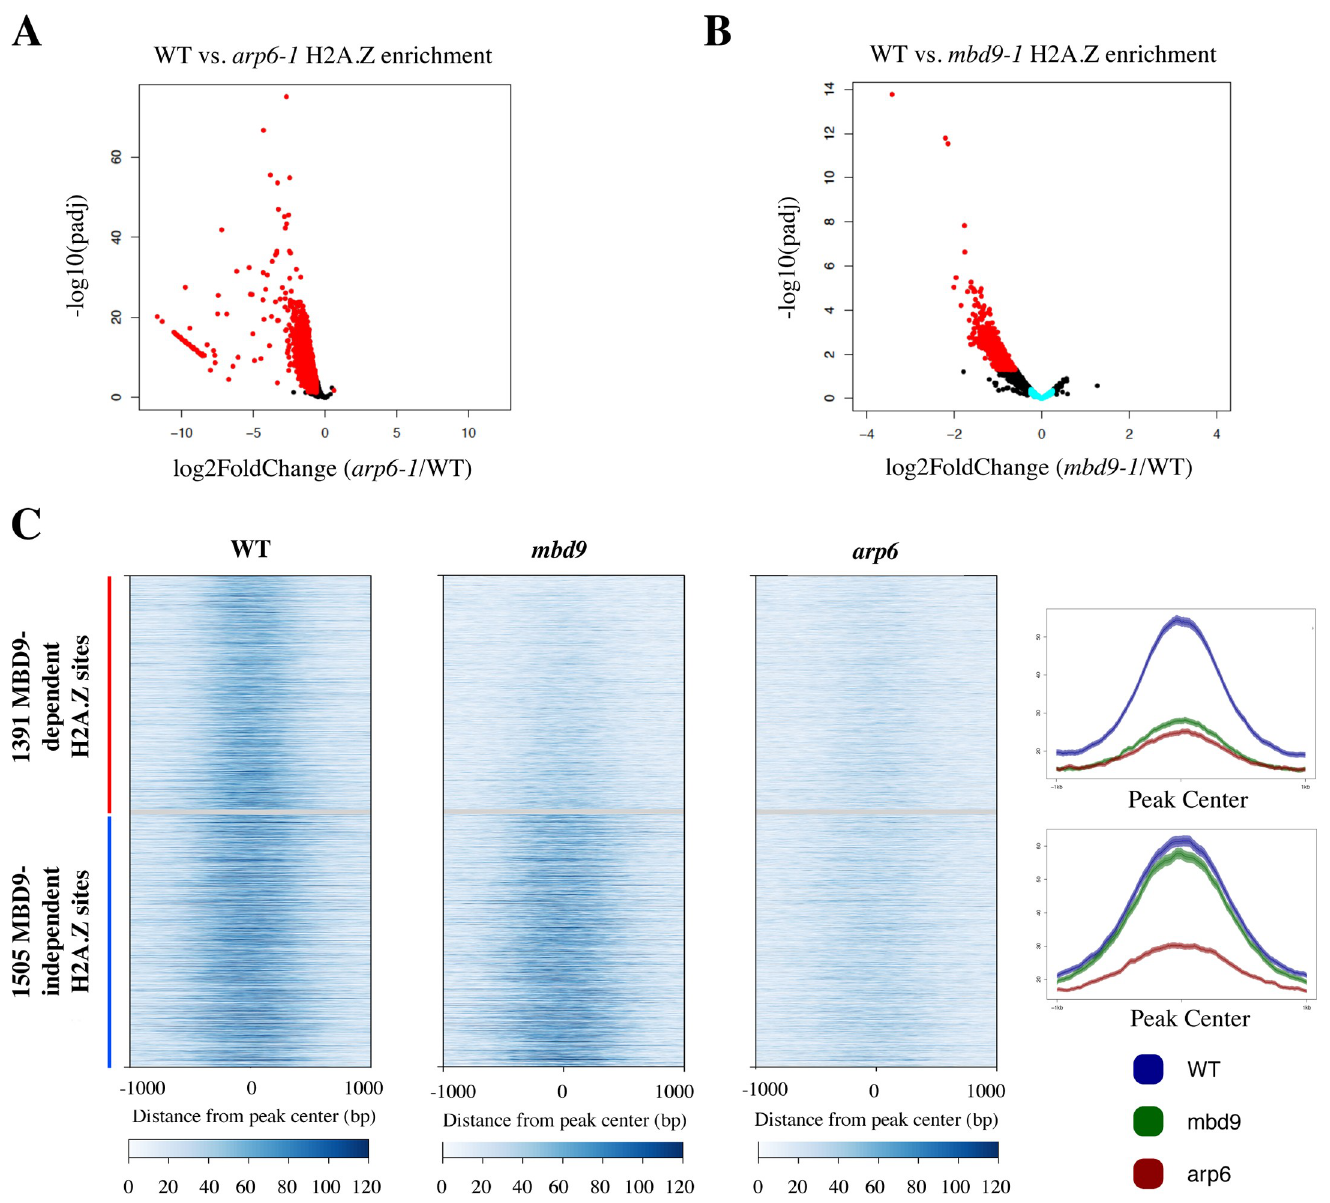
Fig 3. Identification of 1391 H2A.Z-enriched sites that require MBD9 for H2A.Z incorporation into chromatin. (A-B) Volcano plots of–log10 of the adjusted P value (y-axis) versus log2 fold change of H2A.Z ChIP-seq reads (x-axis) between wild type plants and arp6-1 mutant plants (A) or mbd9-1 mutant plants (B). Each point corresponds to a called H2A.Z peak that was analyzed by DESeq2. Peaks that had a log2 fold change equal to or greater than 0.6 and an adjusted p value of 0.05 or less are colored red. Out of 7,039 peaks analyzed, there are 6,266 peaks that are significantly depleted of H2A.Z in arp6-1 plants (A, red dots), and 1,391 peaks that are significantly depleted of H2A.Z in mbd9-1 plants (MBD9-dependent peaks, panel B, red dots). Peaks that had an absolute log2 fold change from 0 to 0.25 in the WT to mbd9-1 comparison are colored light blue (MBD9-independent peaks, panel B, light blue dots). (C) Heatmaps (left) and average plots (right) of the 1391 MBD9-dependent (red bar, top of heatmaps, top average plot) peaks that are significantly depleted of H2A.Z in mbd9-1 plants and 1,505 MBD9-independent (blue bar, bottom of heatmaps, bottom average plot) peaks that had an absolute log2 fold change from 0 to 0.25 in the WT to mbd9-1 plants. Plots are centered on each peak and show a 2 kb window around the peak